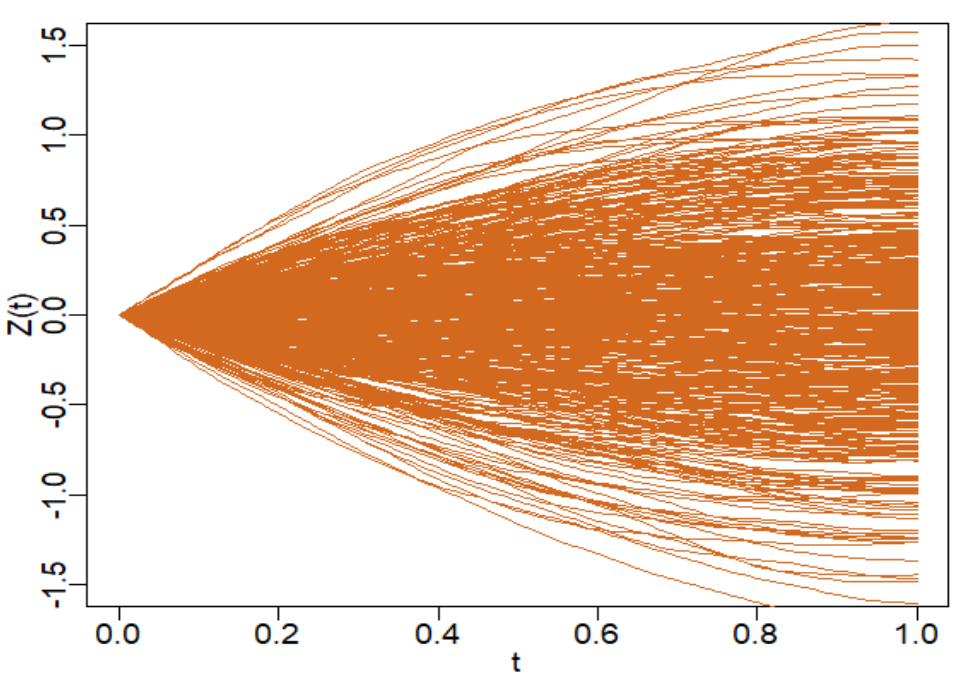
Figure 1. A sample of curves { Z i ( t ) , t ∈ [ 0,1 ] } i = 1,...,500 .